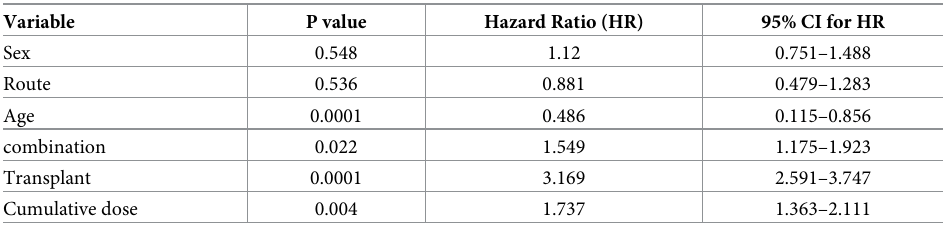
Table 3. Univariate cox regression analysis for total